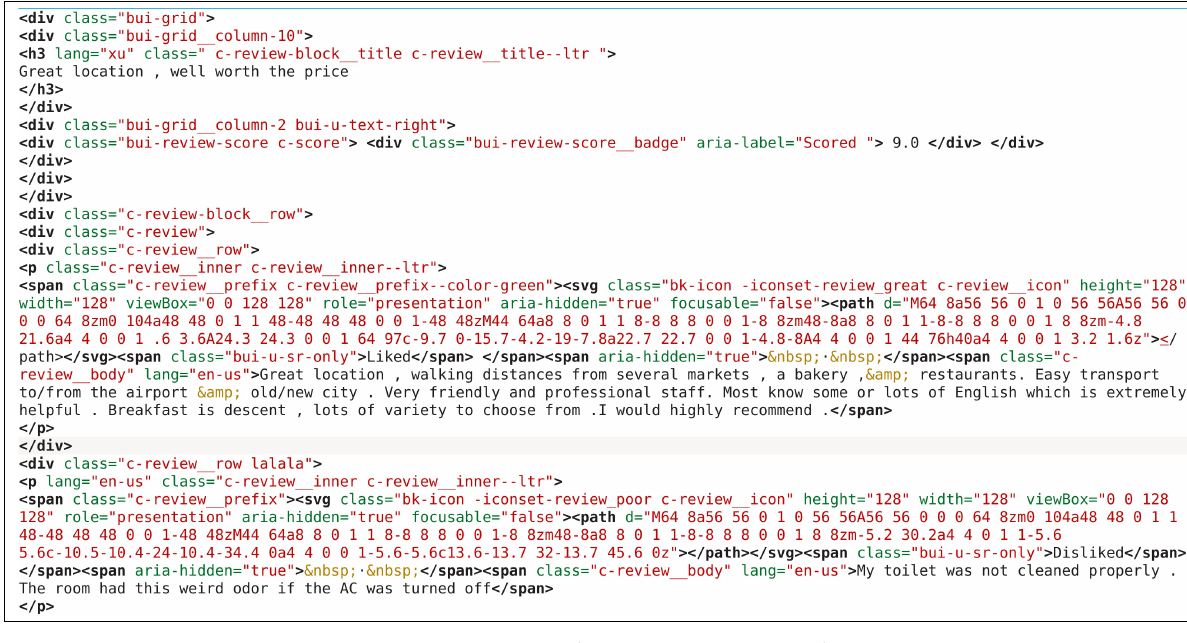
Figure 18. Review data stream: unstructured.